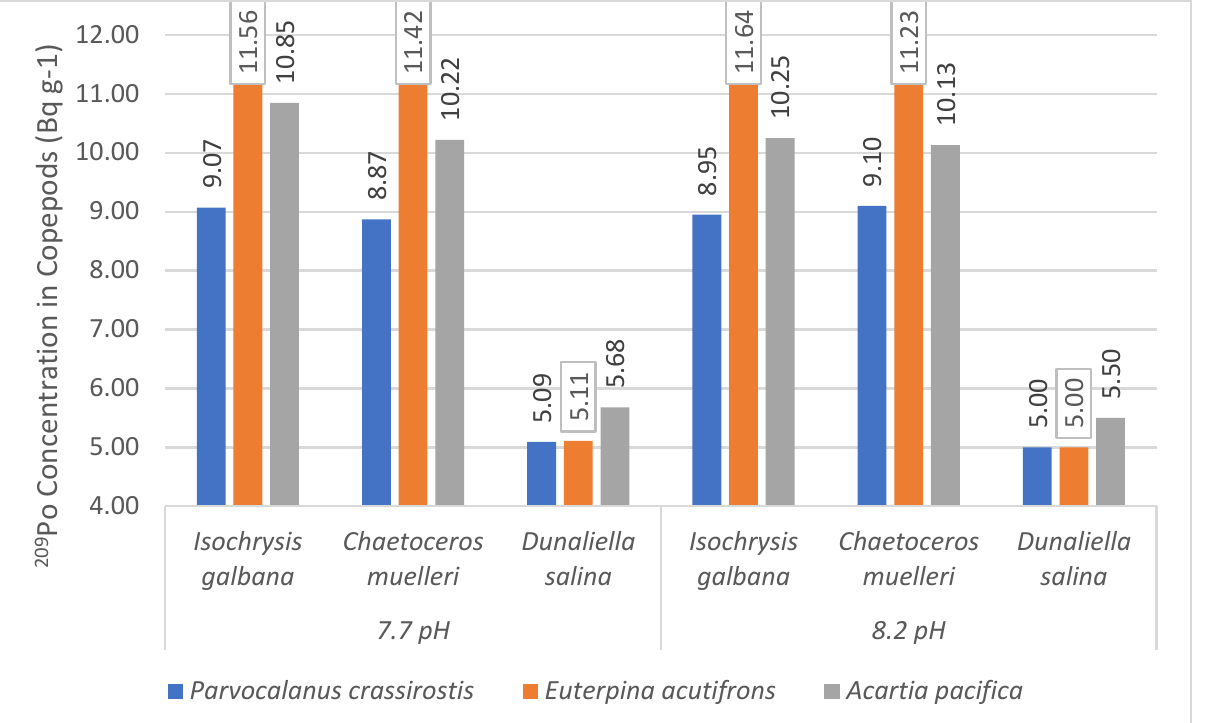
Figure 7. Average 209 Po bioaccumulation in Parvacanus crassitoris , Euterpina acutifrons , and Acartia pacifica ingesting different phytoplankton species at 7.7 and 8.2 pH.